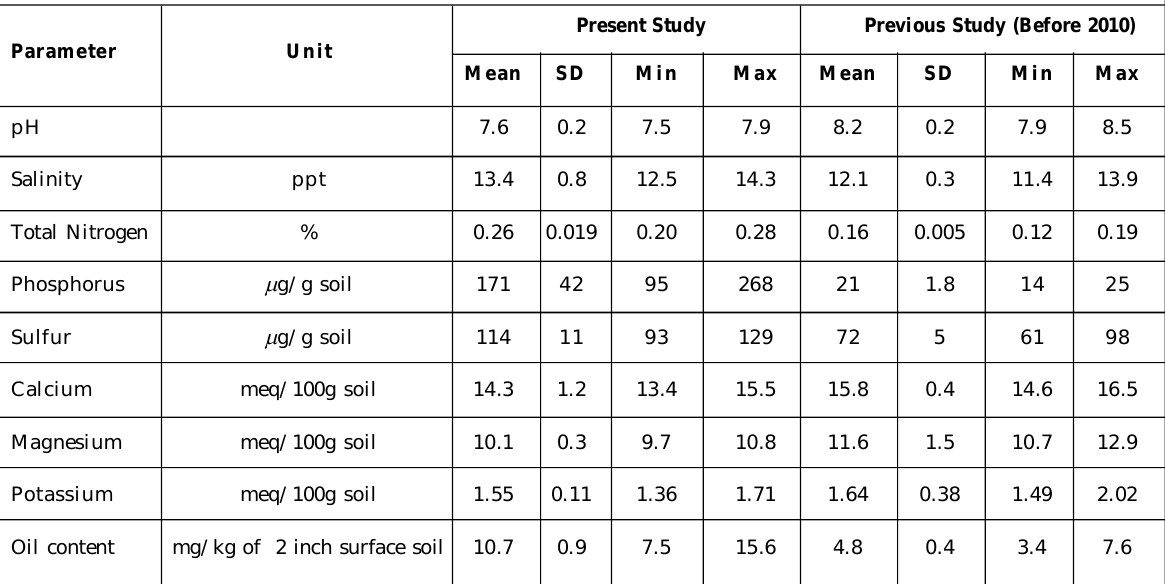
Table 2: Chemical conditions of soil of the study areas (Rampal, Mongla and the Sundarbans) Present Study Previous Study (Before 2010) Parameter Unit Mean SD Min Max Mean SD Min Max pH 7.6 0.2 7.5 7.9 8.2 0.2 7.9 8.5 Salinity ppt 13.4 0.8 12.5 14.3 12.1 0.3 11.4 13.9 Total Nitrogen % 0.26 0.019 0.20 0.28 0.16 0.005 0.12 0.19 Phosphorus  g/g soil 171 42 95 268 21 1.8 14 25 Sulfur  g/g soil 114 11 93 129 72 5 61 98 Calcium meq/100g soil 14.3 1.2 13.4 15.5 15.8 0.4 14.6 16.5 Magnesium meq/100g soil 10.1 0.3 9.7 10.8 11.6 1.5 10.7 12.9 Potassium meq/100g soil 1.55 0.11 1.36 1.71 1.64 0.38 1.49 2.02 Oil content mg/kg of 2 inch surface soil 10.7 0.9 7.5 15.6 4.8 0.4 3.4